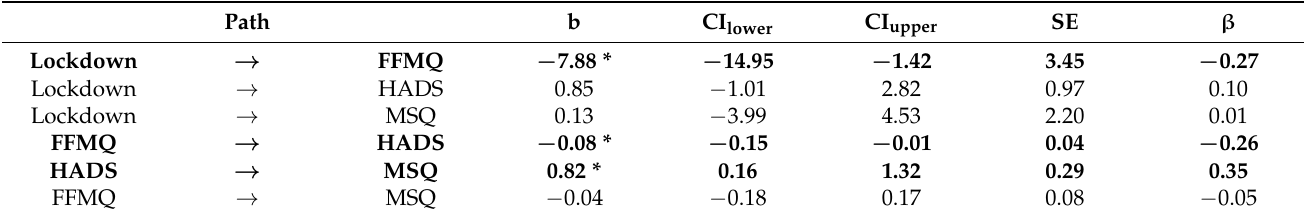
Table 2. SEM estimated coefficients for model 1.